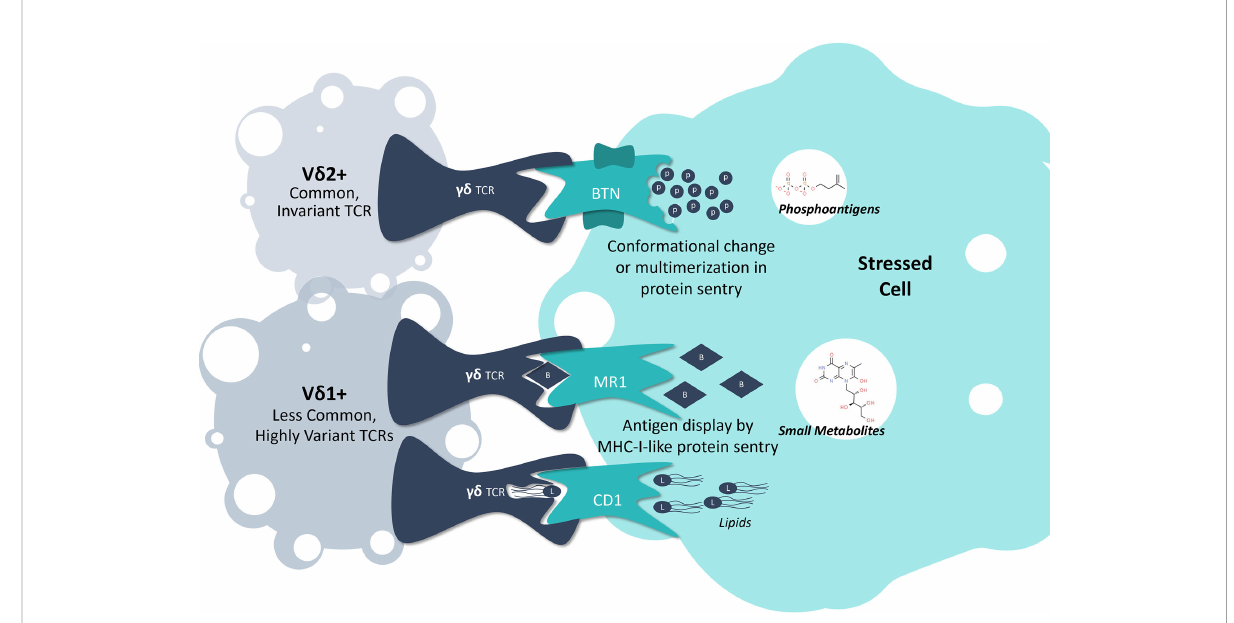
FIGURE 1 gd T Cell Detection of Intracellular Stress. A collection of sentry proteins monitor the intracellular space for speci fi c molecular signs of stress, including butyrophilins monitoring for phosphoantigen levels, MR1 monitoring for small metabolites indicative of tumor development or cancer, and CD1 monitoring for lipids. By interacting with these protein sentries, gd T cells can detect when a cell is under stress and initiate an effector